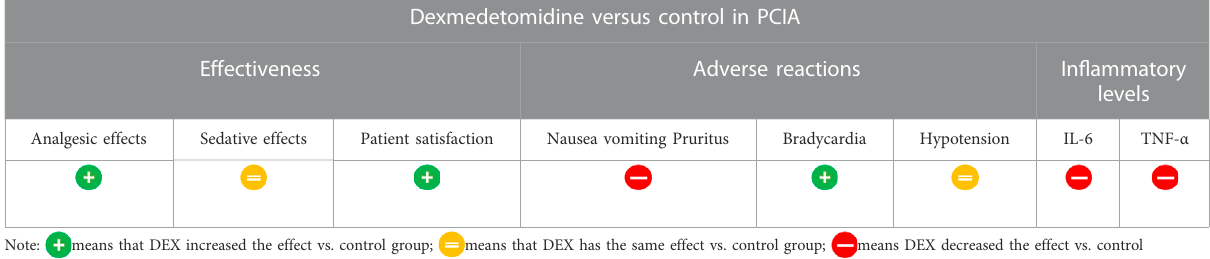
means that DEX has the same effect vs. control